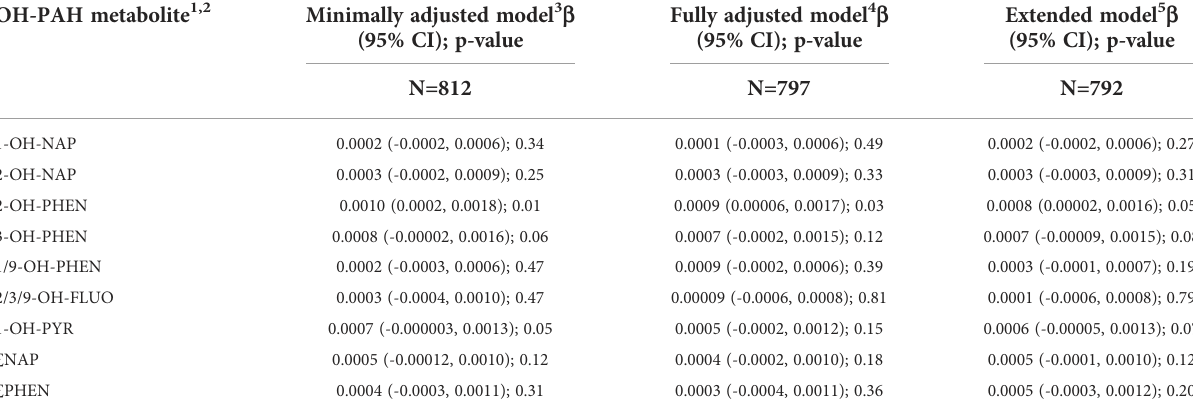
TABLE 3 Mixed effect models examining log-transformed PAH metabolite concentrations in relation to change in pCRH concentrations across mid-late pregnancy.